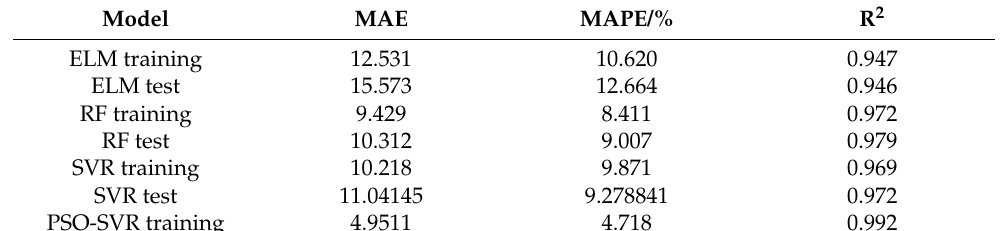
Table 2. Definitions of evaluation indexes.